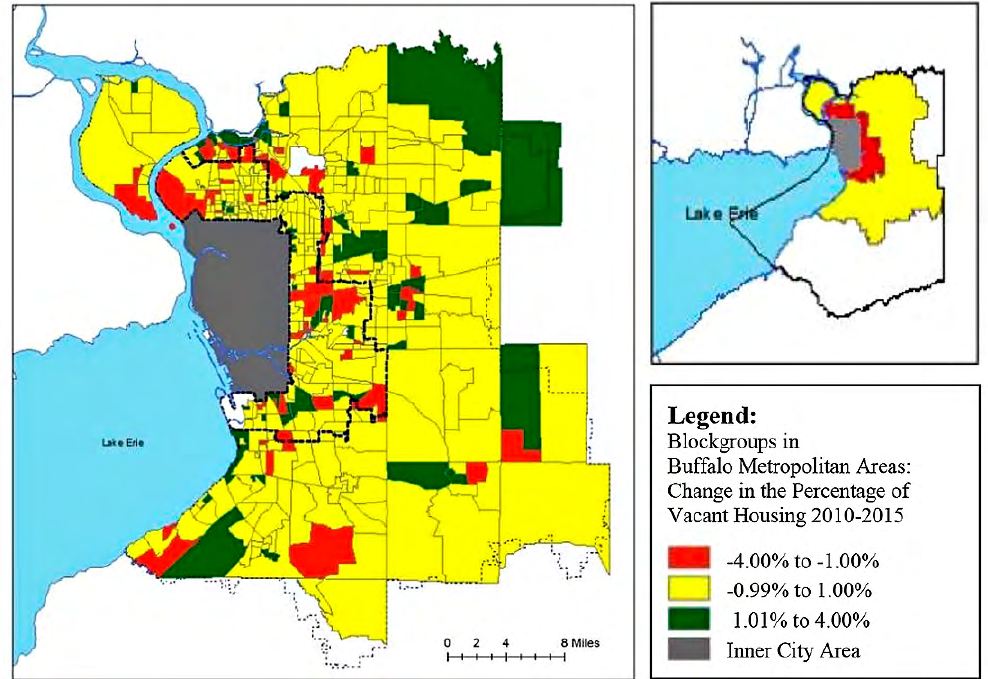
Figure 4. The third component contributing to Neighbourhood Change between 2010-2015 (The Percentage of Vacant